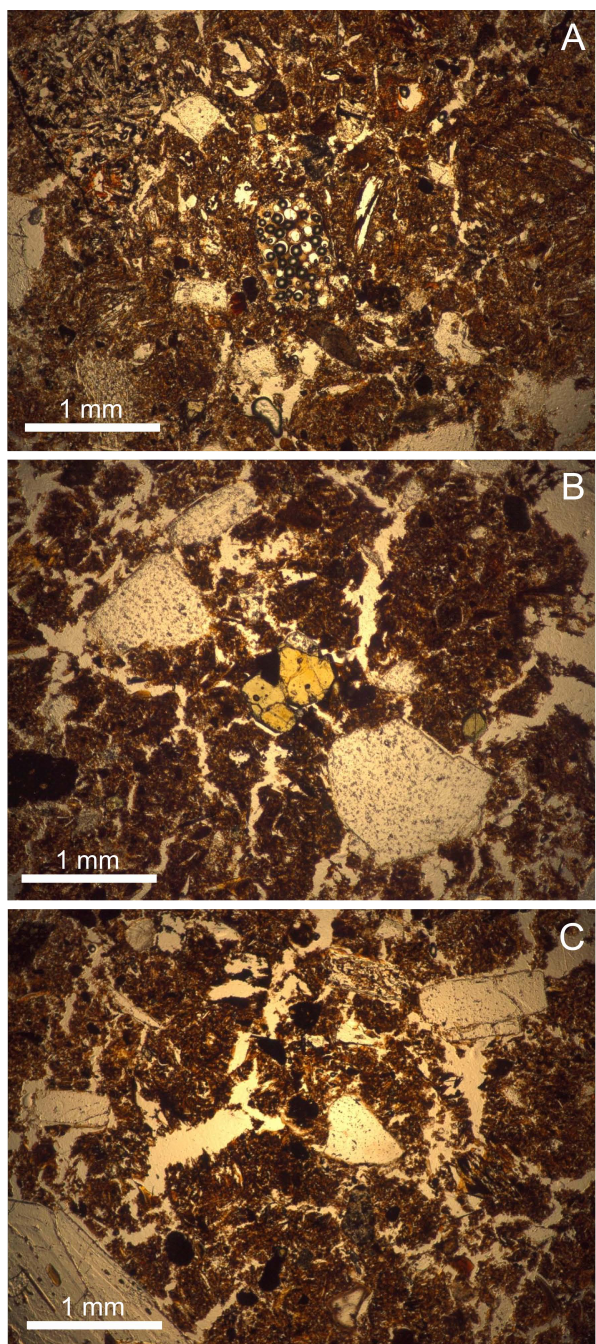
Fig. 12. Optical microscope images of Neapolitan Yellow Tuff ther- mally stressed to a temperature of 1000 ◦ C showing macrocracks. The photomicrograph in panel A, showing foaming, is taken from Heap et al.